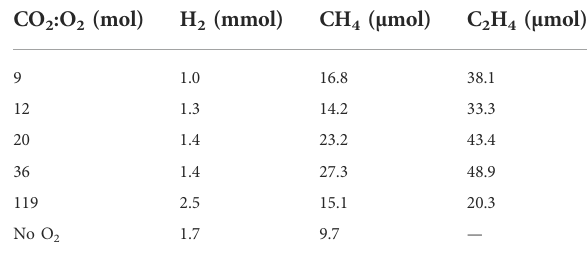
TABLE 2 Hydrogen and hydrocarbons detected in the gas phase at different CO 2 :O 2 mole ratios. Reaction conditions: T = 300 °